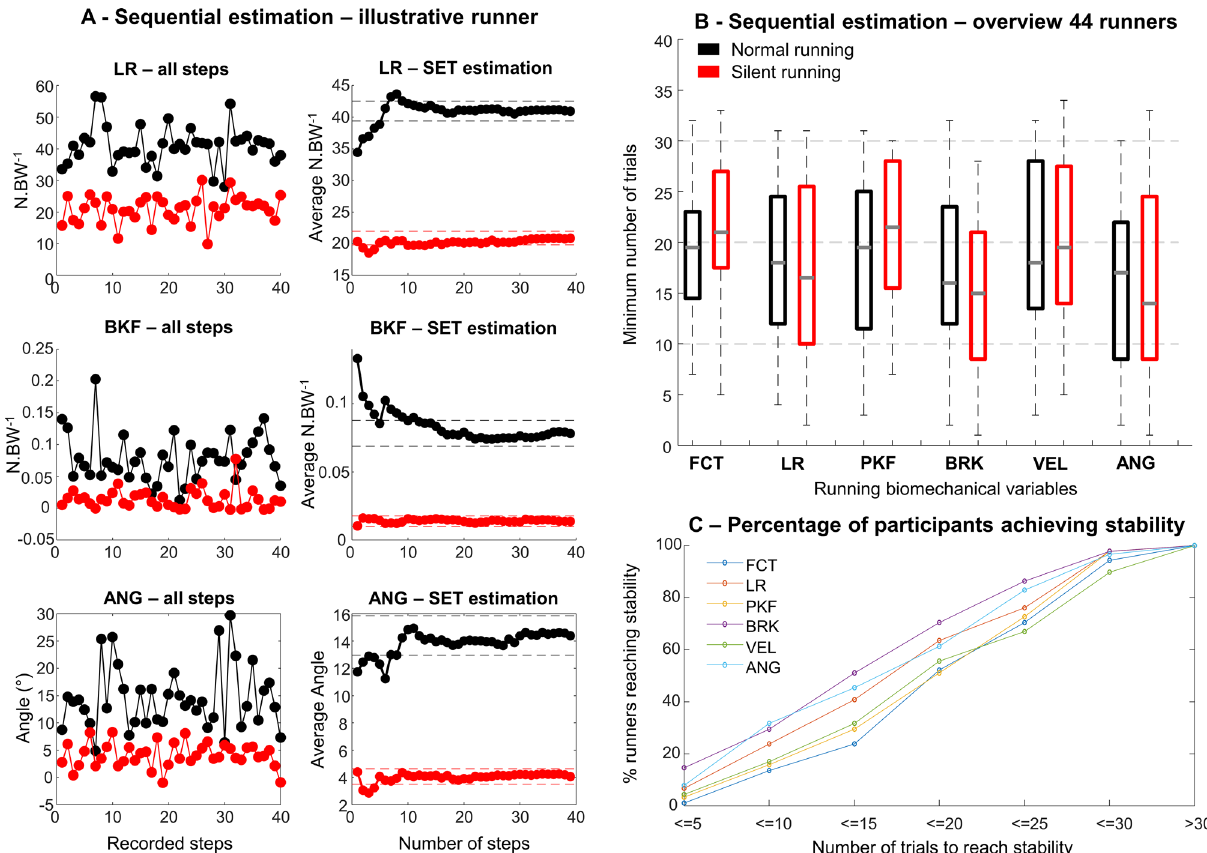
Figure 4. Illustration of sequential estimation to determine the number of steps needed to achieve stability from 10 (left) and 40 runners (right) during both normal (black) and silent running (red). ( A ) Within parameter variability of a representative runner (left) and sequential estimations (right) for loading rate (LR), peak braking force (BKF), and foot contact angle (ANG). ( B ) Box plots represent 25th and 75th percentiles, and data range ( dashed vertical lines ) for multiple parameters (foot contact time—FCT, loading rate—LR, peak vertical force— PKF, peak braking force—BRK, running speed—VEL, foot contact angle—ANG). ( C ) The linear plots illustrate parameter variability and the percentage of participants as well as the number of steps required to achieve stability across both normal and silent running.